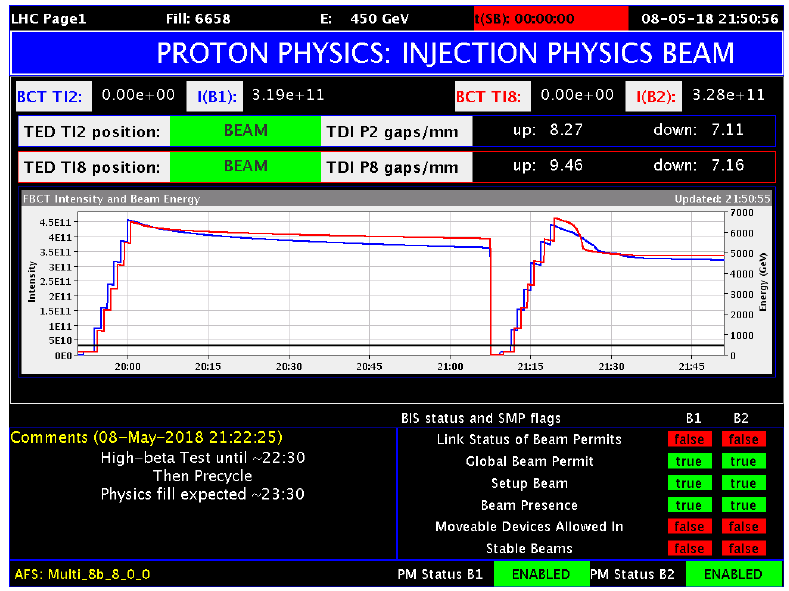
Figure 3. 8 May 2018, immediate